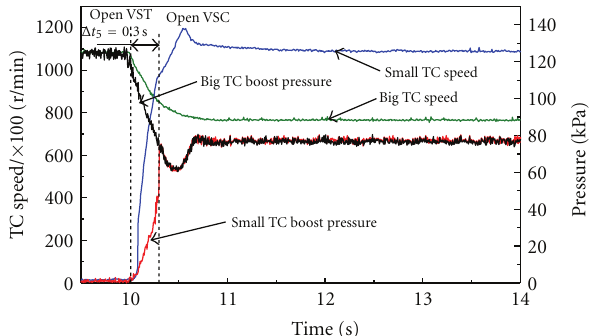
Figure 11: Process from the 2TC to the big TC with Δ t 6 = 0 . 3s.